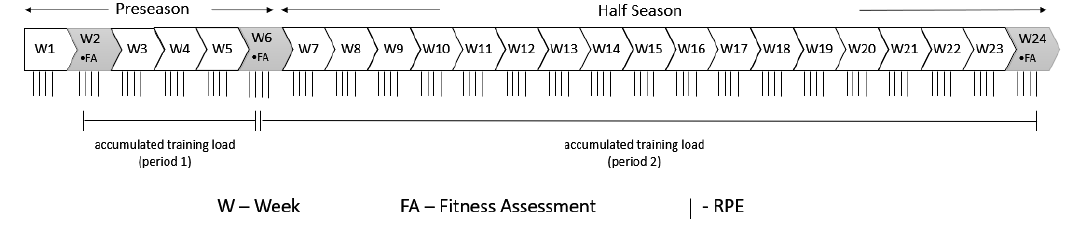
Figure 1. Timeline of the study.